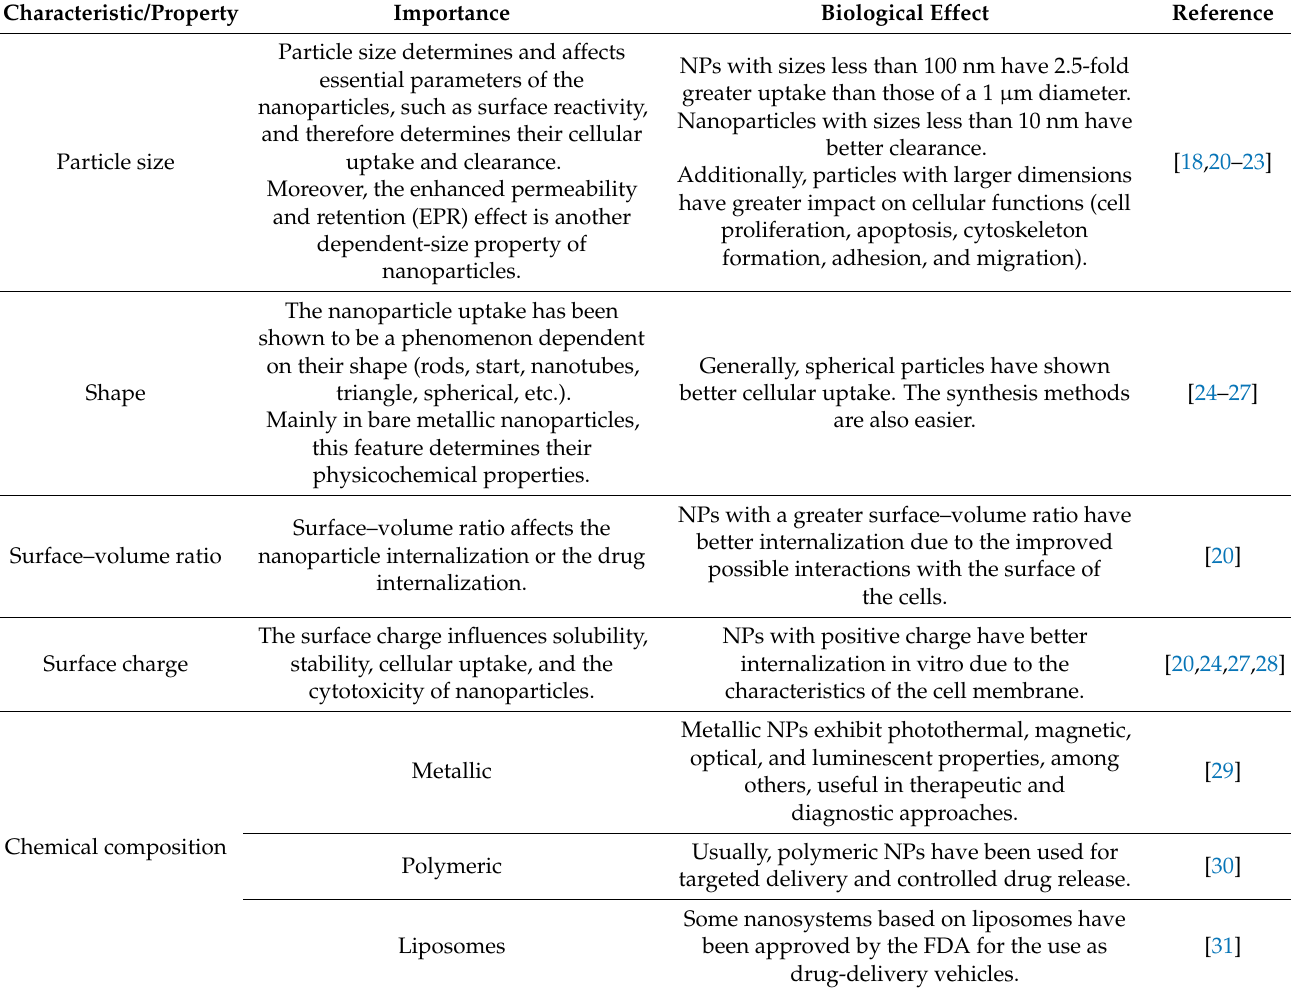
Table 1. Importance of nanoparticle properties in biological